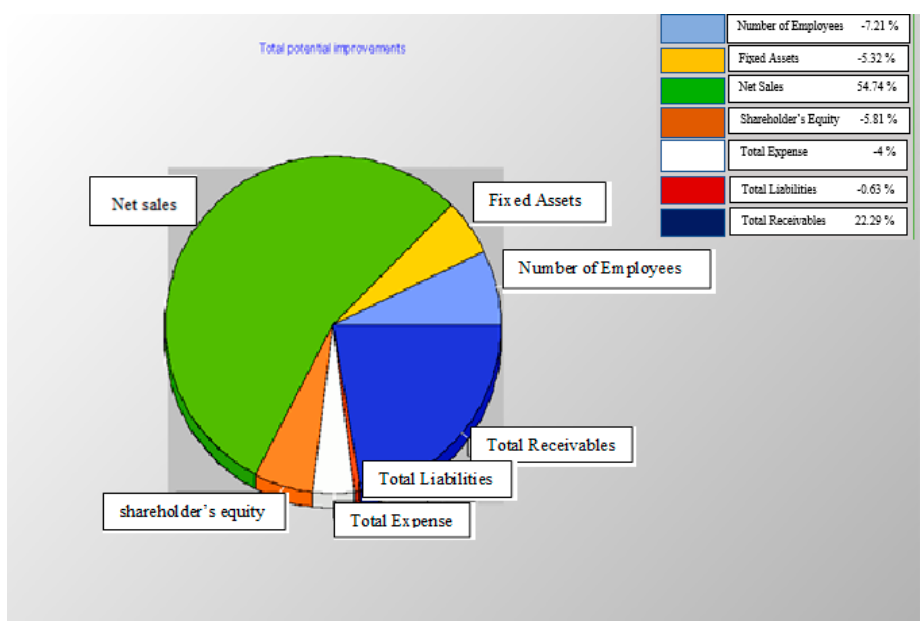
Figure 4. Efficiency boundary.